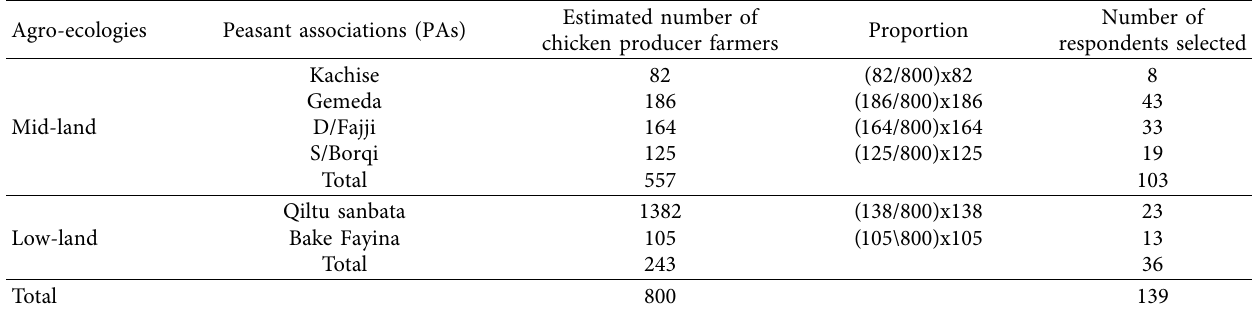
Table 1: Proportionate distribution of poultry farmers according to district agro-ecological zones.